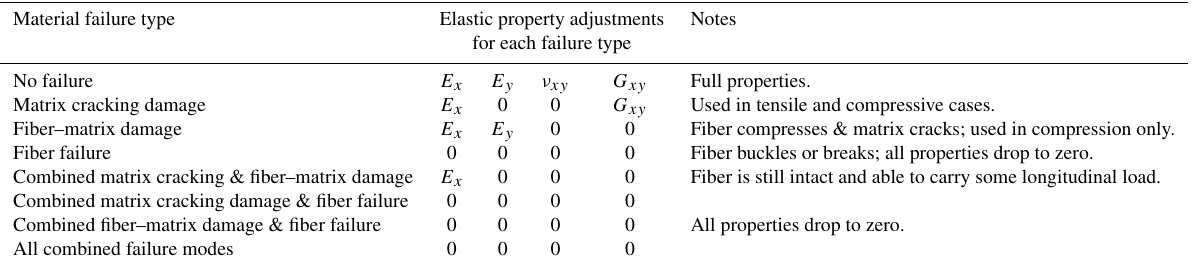
Table 3. Progressive damage analysis degradation for user-defined criteria. Material failure